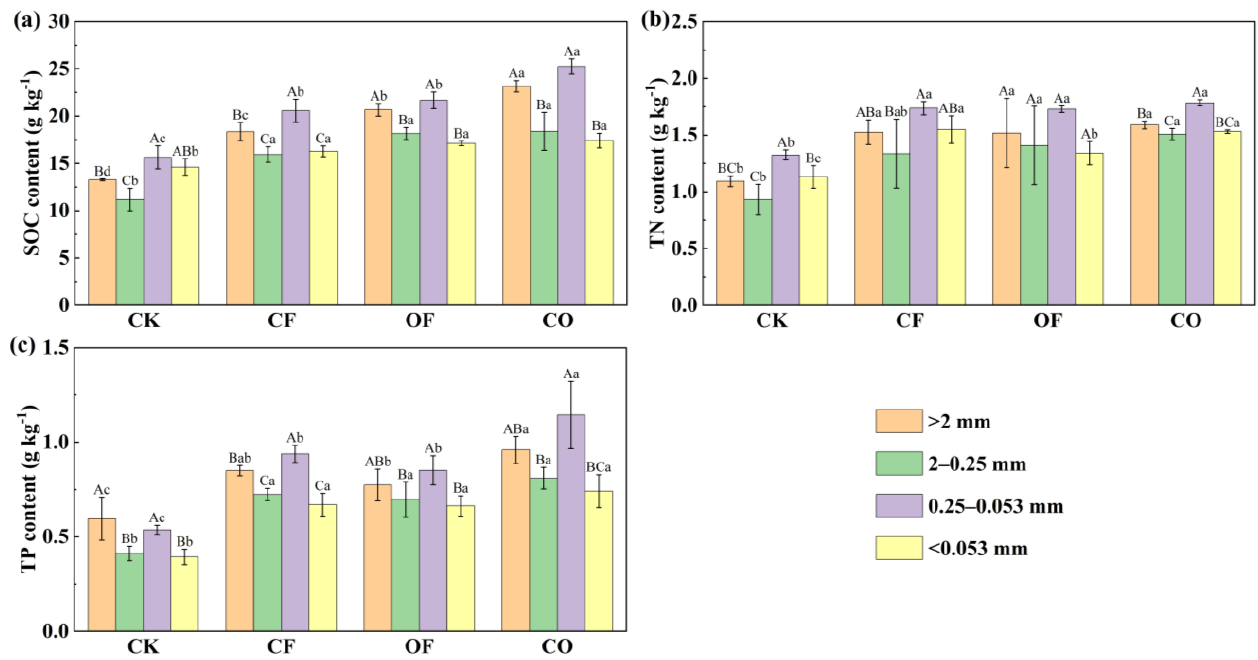
Figure 2. The content of SOC ( a ), TN ( b ), and TP ( c ) in soil aggregate following different treatments. Different uppercase letters indicate significant differences in aggregate fraction within the same treatment ( p < 0.05), and different lowercase letters indicate significant differences between different treatments within the same aggregate fraction ( p < 0.05). CK, no fertilizer; CF, chemical fertilizer; OF, organic fertilizer; CO, chemical fertilizer (50% N) plus organic fertilizer (50%